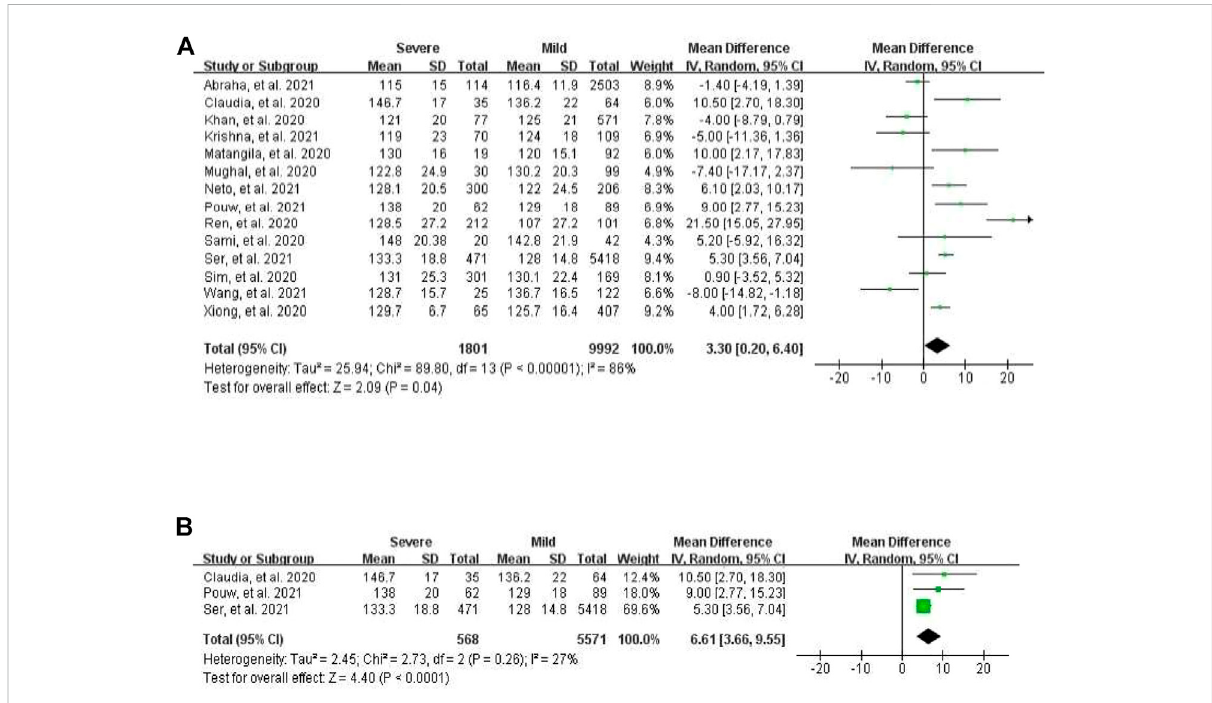
Forest plot for the meta-analysis of mean difference of SBP between severe and mild cases. (A) In all populations; (B) in the European